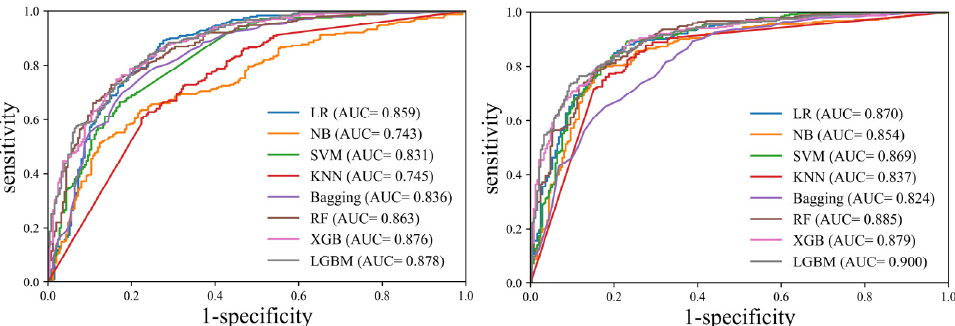
Figure 4. Comparison of ROC curves of the various machine learning models. Left graph: ROC curves without feature selection. Right graph: ROC curves with feature selection. LR, logistic regression; NB, naive Bayes; SVM, support vector machine; KNN, k-nearest neighbor; RF, random forest; XGB, extreme gradient boosting; LGBM, light gradient boosting machine; ROC, receiver operating characteristic; AUC, area under the curve.